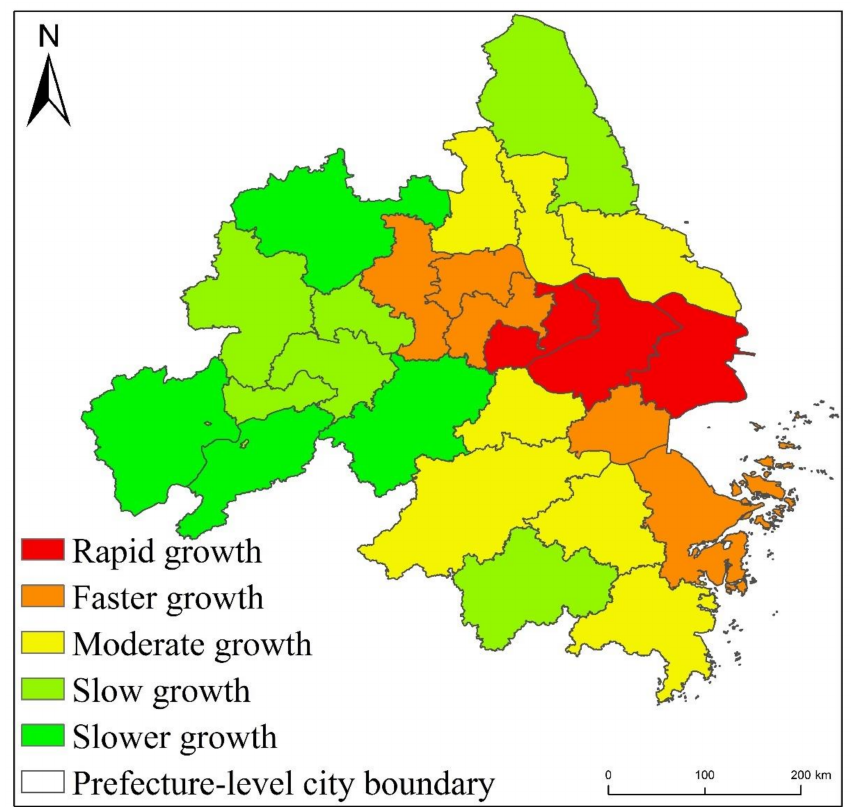
Figure 9. Statistical chart of EPC change trend of YRDUA from 1992 to